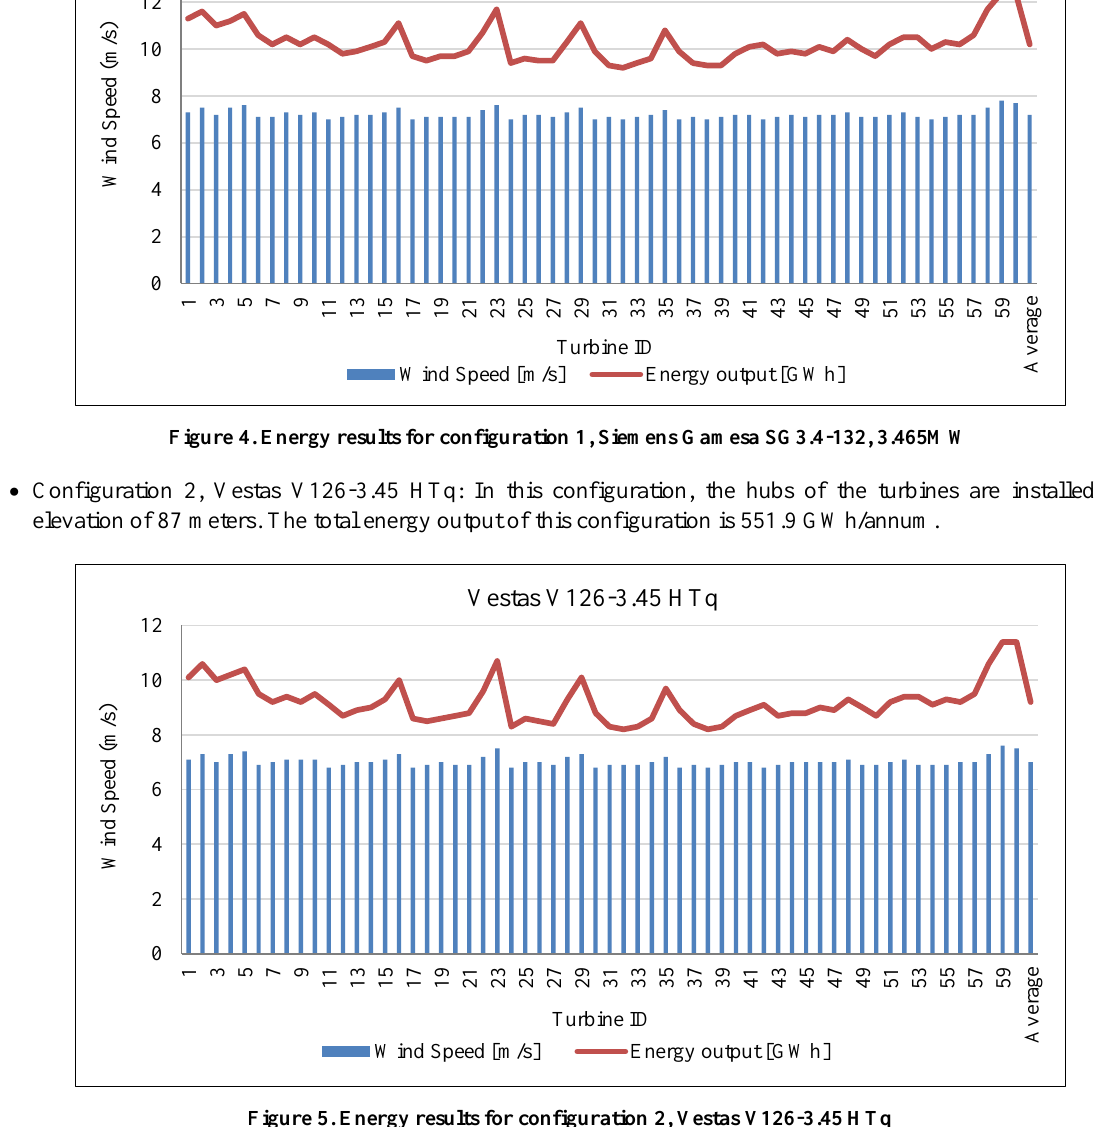
Figure 5. Energy results for configuration 2, Vestas V126-3.45